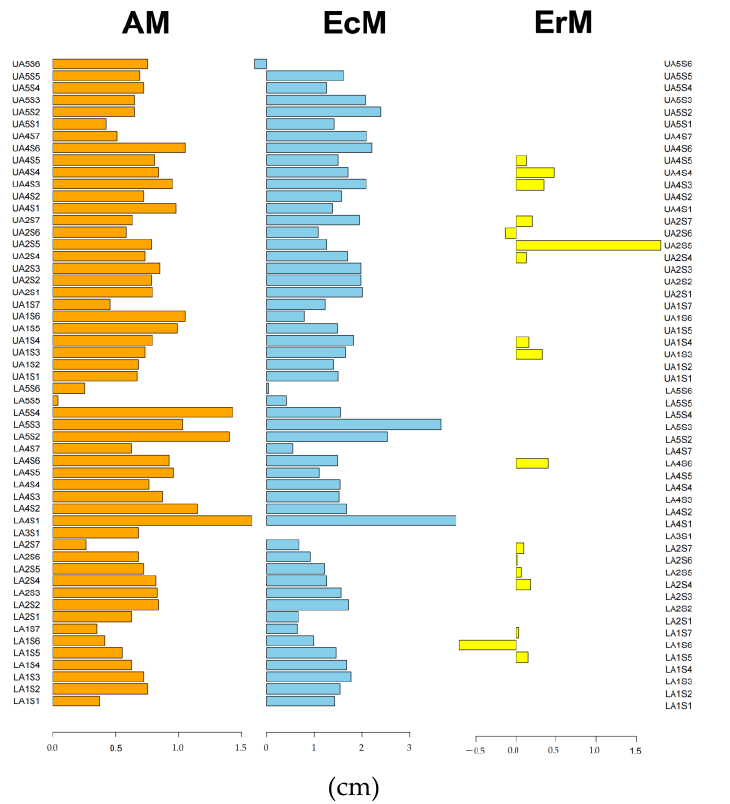
Figure 4. ( a ) Number variation diagram of tree species with different mycorrhizal types in different microtopography types from 2013 to 2018. ( b ) DBH sum variation diagram of tree species with different mycorrhizal types in different microtopography types from 2013 to 2018. ( c ) Mean DBH variation diagram of tree species with different mycorrhizal types in different microtopography types from 2013 to 2018. AM represents tree species with arbuscular mycorrhizal type. EcM represents tree species with ectomycorrhiza type. ErM represents tree species with ericoidmycorrhiza type.